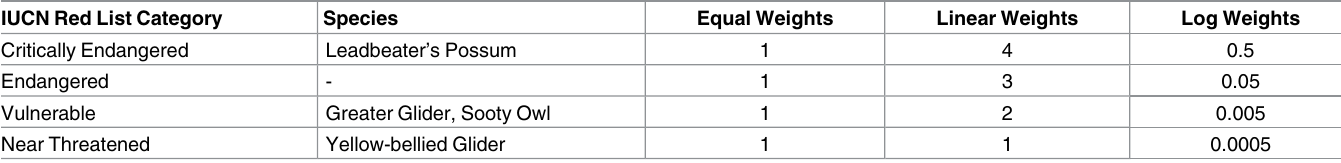
Table 1. Three weighting schemesfor IUCN Red List categories used in this study.